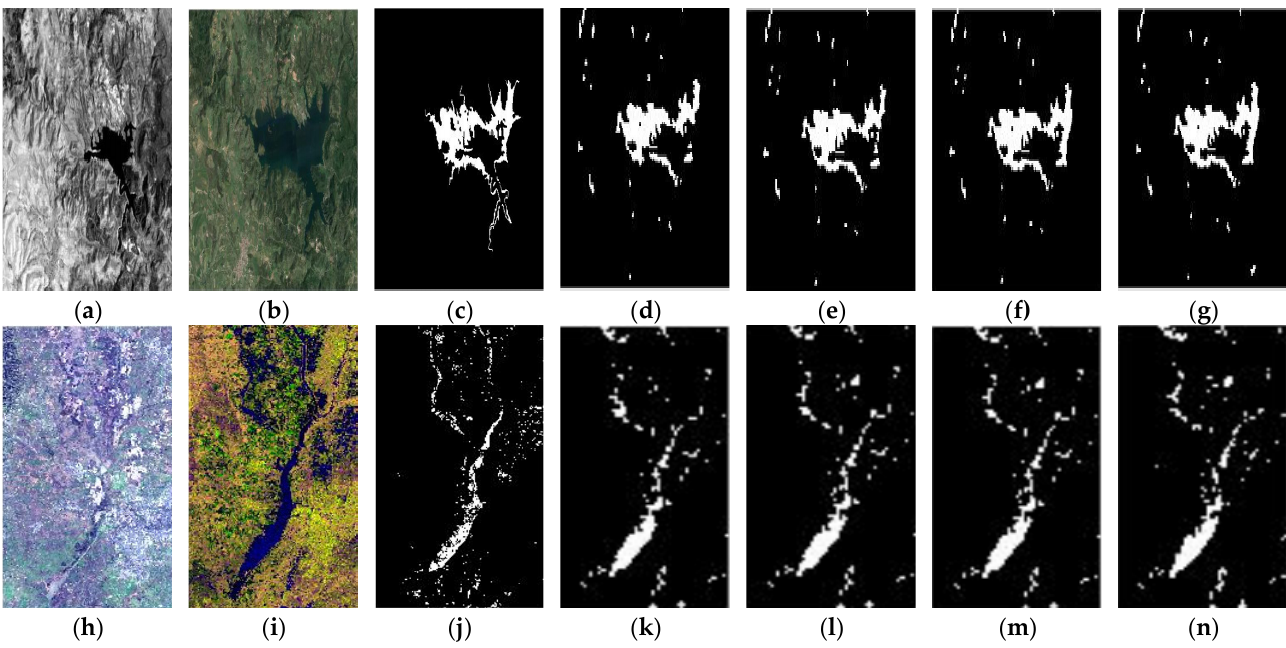
Figure 2. Performance comparison: ( a ) pre-event of Italy; ( b ) after-event of Italy; ( c ) ground truth of Italy; ( d ) INLPG of Italy; ( e ) FDCCN of Italy; ( f ) our method without newly built convolution kernel of Italy; ( g ) our method with newly built convolution kernel of Italy; ( h ) pre-event of California; ( i ) after-event of California; ( j ) ground truth of California; ( k ) INLPG of California; ( l ) FDCCN of California; ( m ) our method without newly built convolution kernel of California; ( n ) our method with newly built convolution kernel of California. Table 3. The performance comparison for Italy between our proposed method and state-of-the- art approaches.